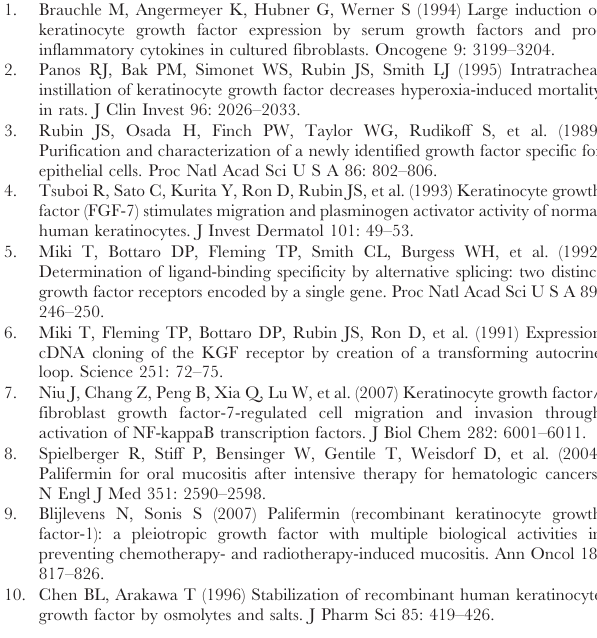
Figure S1 SDS-PAGE and CD analysis of Mal-PEGylated rhKGF-1. Panel A. SDS-PAGE analysis of solution-phase Mal- PEGylation of rhKGF-1 in the absence or presence of 2 M urea. Lane M, molecular weight standards; lanes a and b correspond to the PEGylation reaction mixtures in the absence of 2 M urea; lanes c and d correspond to the PEGylation reaction mixtures in the presence of 2 M urea. Panel B. Far-UV CD spectra of non- PEGylated (black line), solid-phase PEGylated rhKGF-1 (red line) and solution-phase Mal-PEGylated rhKGF-1 (blue line). The ellipticities are reported as mean residue ellipticity (MRE) (deg cm2 dmol-1). Panel C. Ribbon presentation of KGF-1 structure. Amino (N) and carboxyl (C) terminal ends are indicated, the Cys